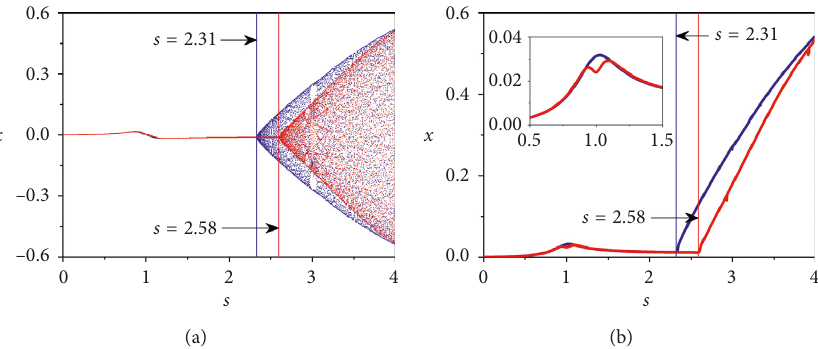
Figure 14: (a) The bifurcation diagram and (b) the amplitude-frequency response curve of the rotor/seal system attached with the DVA in the x